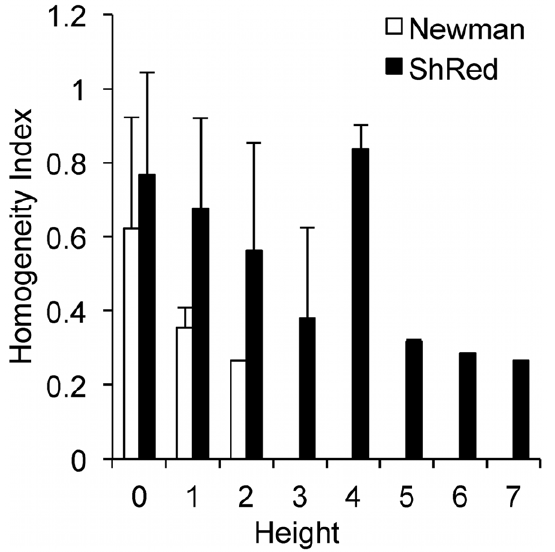
Figure 6. Effects of the partition metric on the properties of hepatocyte network modules. Homogeneity index is shown as a function of partition height. The height of the root node in the Newman partition tree is 2, whereas the height of the ShReD tree is 7. Error bars represent one standard deviation.